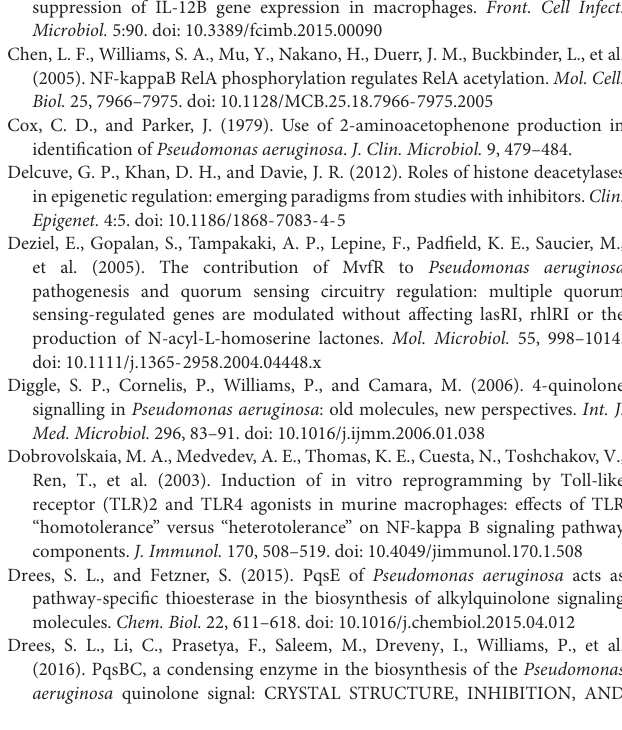
FIGURE S3 | 2-AA tolerization induces interaction between NF- κ B p50 and HDAC1 and disrupts p65-CBP/p300 binding. (a) Co-IP assay showing increased p50/HDAC1 interaction in 2-AA-tolerized mouse macrophage RAW264.7 cells following 2-AA stimulation (1 h). (b) Co-IP assay confirming that 2-AA tolerization inhibits interaction of p65 with CBP and p300 in THP-1 cells. WB, Western blot. Data are representative of three independent